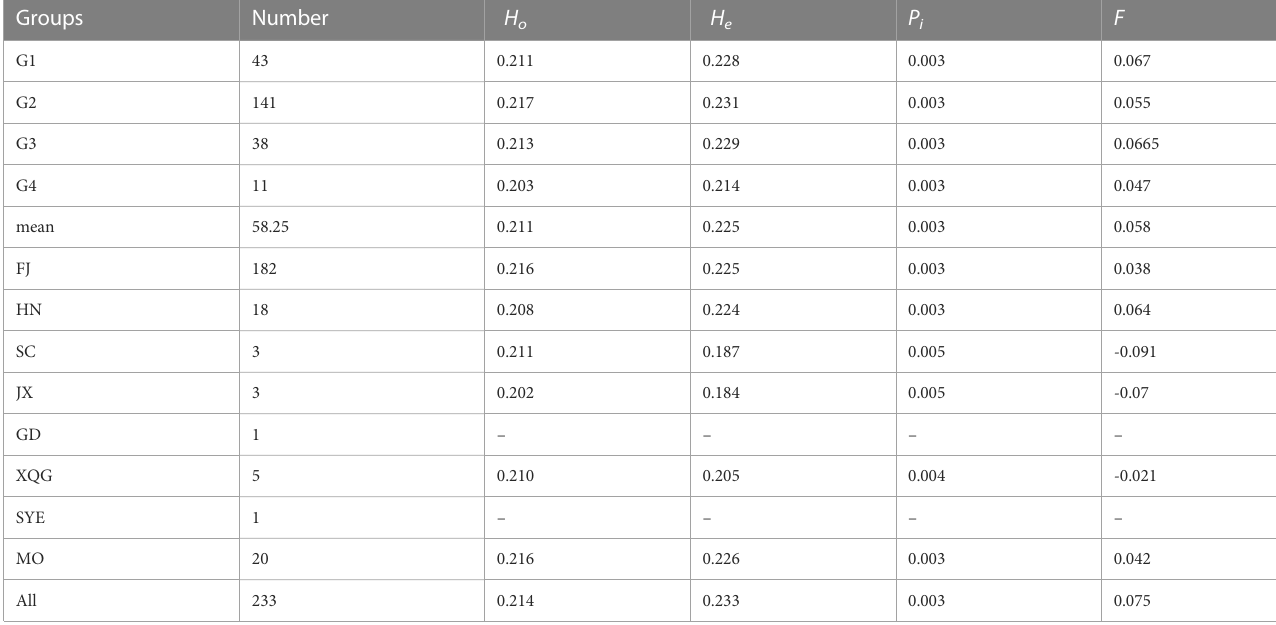
TABLE 1 Genetic diversity parameters of the Chinese fi r 4 th cycle breeding population.